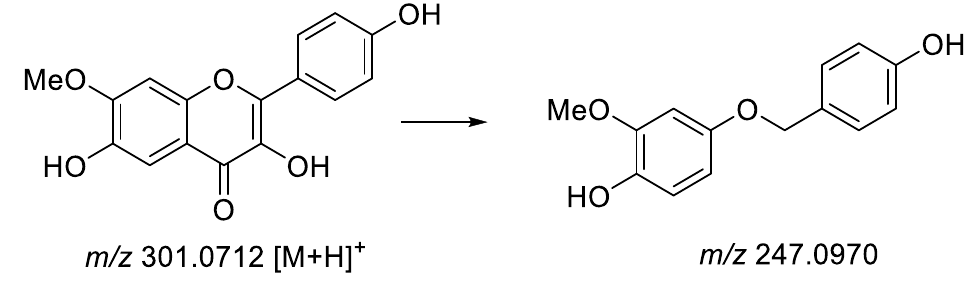
Figure 3. Fragmentation pattern for the flavonol.